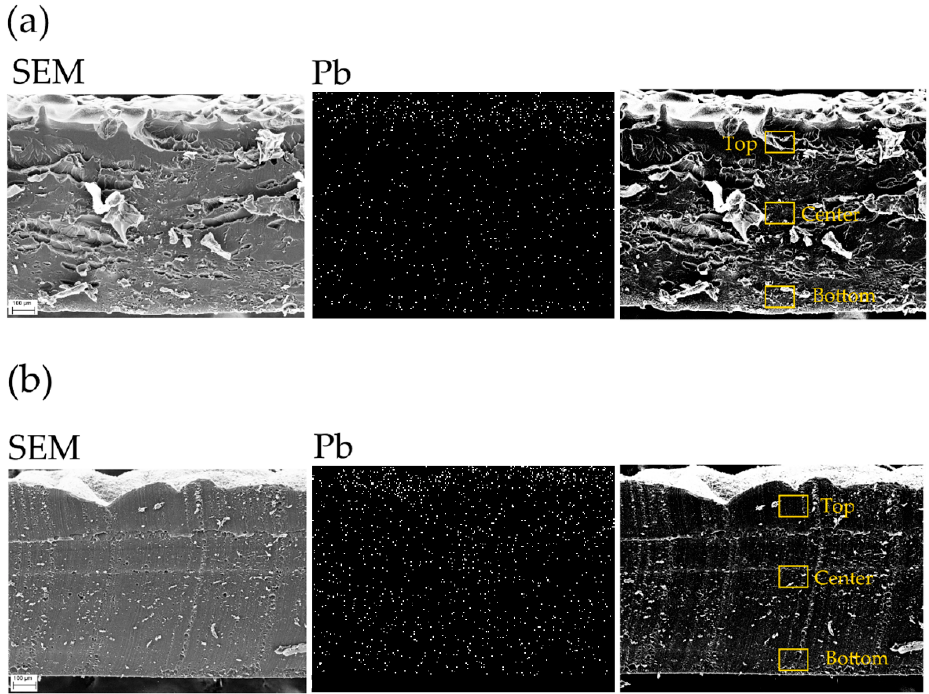
Figure 4. EDX analyses results of 14% PEGDA samples without (1–0, ( a )) and with (1-C, ( b )) after the filtration of 1500 ppm Pb(II). For each sample, the SEM image of the recorded area and the Pb distribution map are reported. The yellow boxes in the third panel underline the areas where the localized EDX spectra were acquired. The obtained elemental distributions of localized analyses are reported in Table S1. Table 2. Elemental composition of the AgNCs-free and AgNCs hydrogels after the filtration of a 1500 ppm of Pb(II) solution.